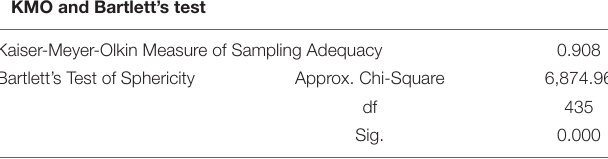
TABLE 6 | Bartlett’s test and Kaiser–Meyer–Olkin